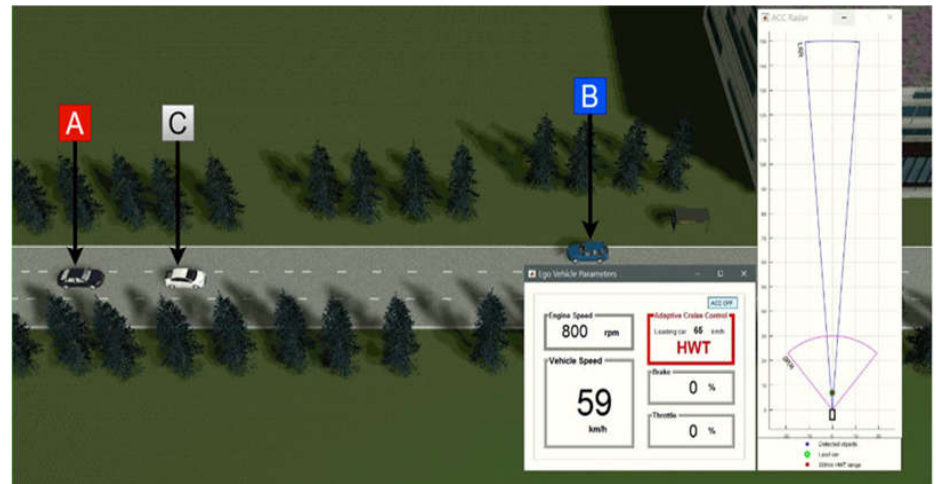
Figure 10. Vehicle A with TIS sensors in PreScan.